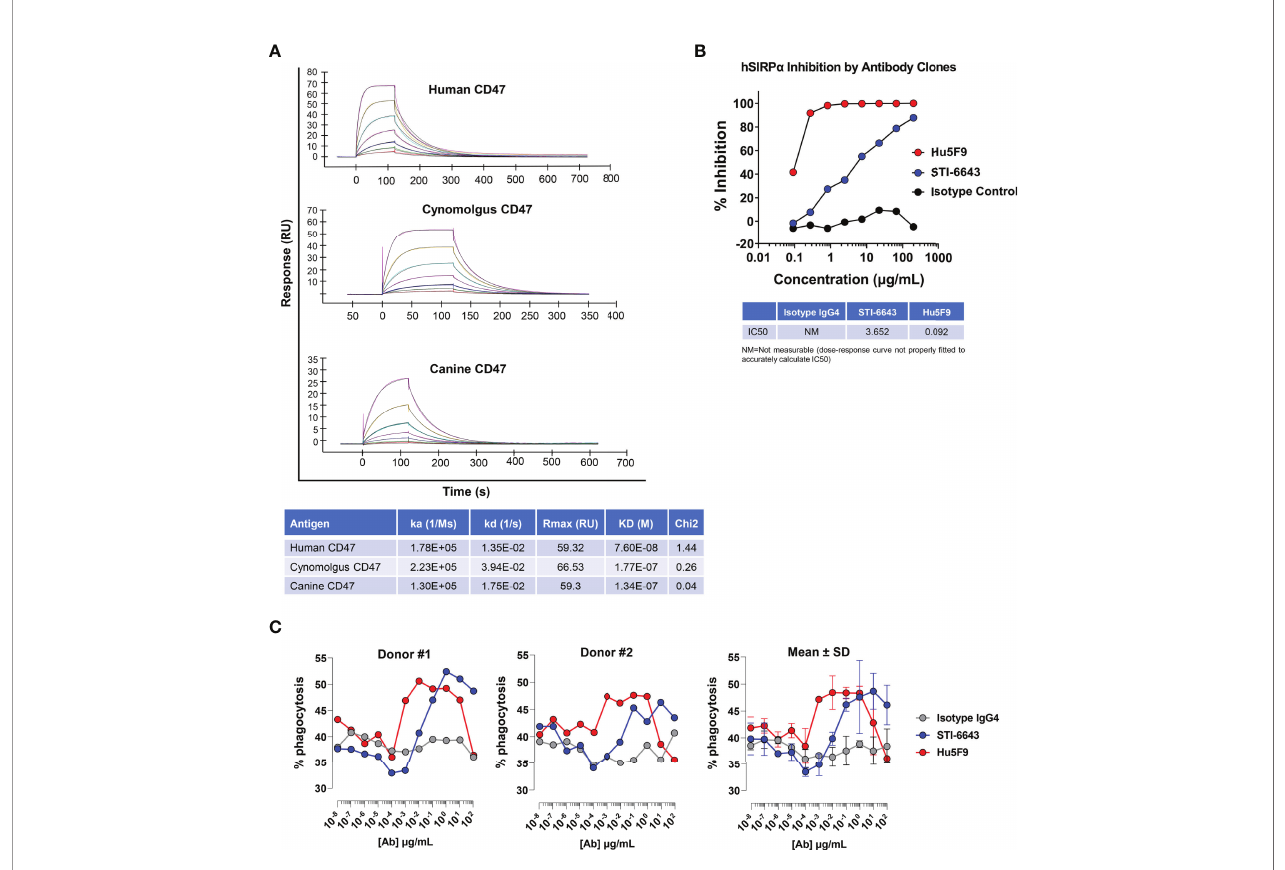
FIGURE 1 | Kinetics and functional properties of human anti-CD47 clone STI-6643. (A) The kinetic binding parameters of STI-6643 to human (top panel), cynomolgus (middle panel) and canine (bottom panel) CD47 ligands were measured using the BIACORE and are given in the Table. (B) Blockade of the SIRP a / CD47 interaction by anti-CD47 clones STI-6643 (blue) and Hu5F9 (red) with a range of dose from 0.1 to 200 µg/mL. IC50 values are provided in the Table. NM, not measurable. (C) Phagocytosis of RAJI-GFP cells by CD14 + monocytes derived macrophages isolated from the PBMCs of two different donors (left and middle panel) in presence of STI-6643 (blue) and Hu5F9 (red) anti-CD47 antibodies or control isotype IgG 4 (grey) antibodies. Cumulative data from both experiments are presented in the right panel. Data are representative of two (A) , two (B) , three (C) independent